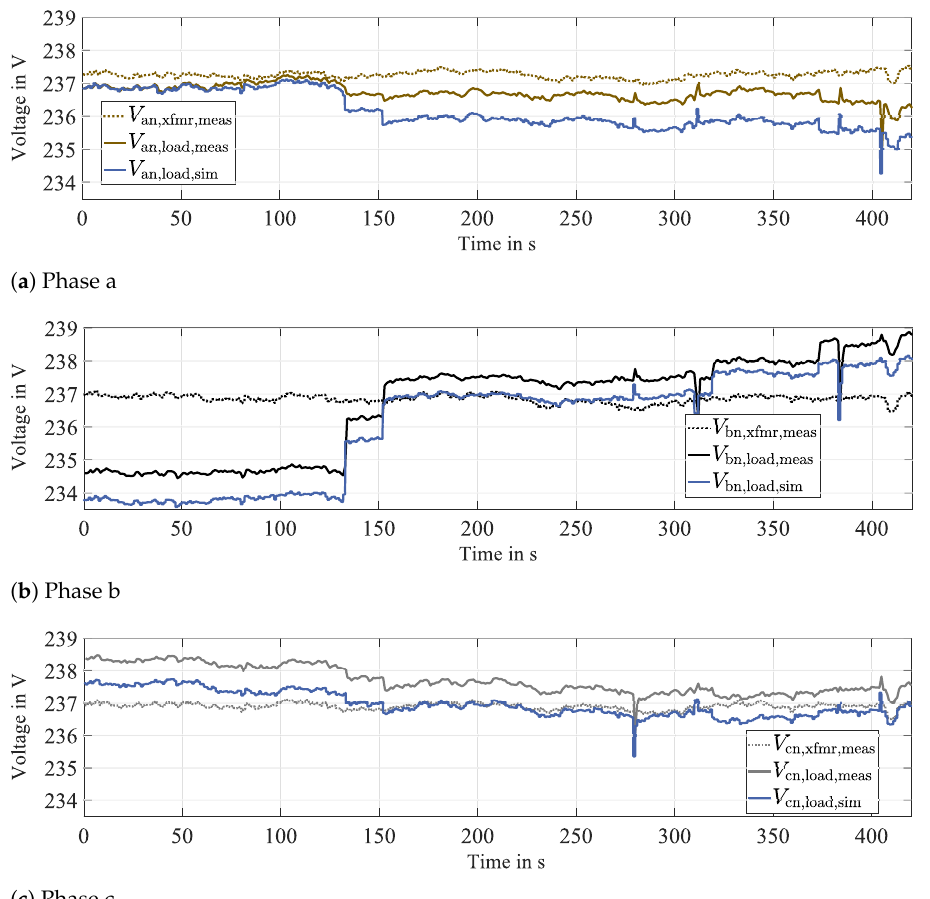
Figure 22. Comparison of measured and simulated phase